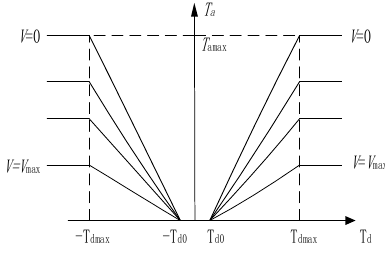
Table 2. Test set prediction